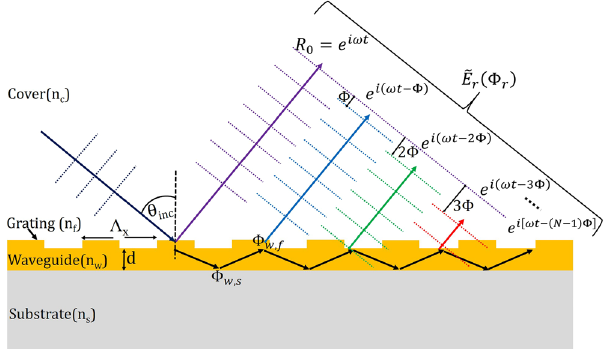
Figure 1. GMR structure explaining phase detection. A 1D subwavelength grating coupled to a waveguide to form the GMR structure. The change in the phase ( Φ r ) of the resultant complex wave (  E response to surrounding RI